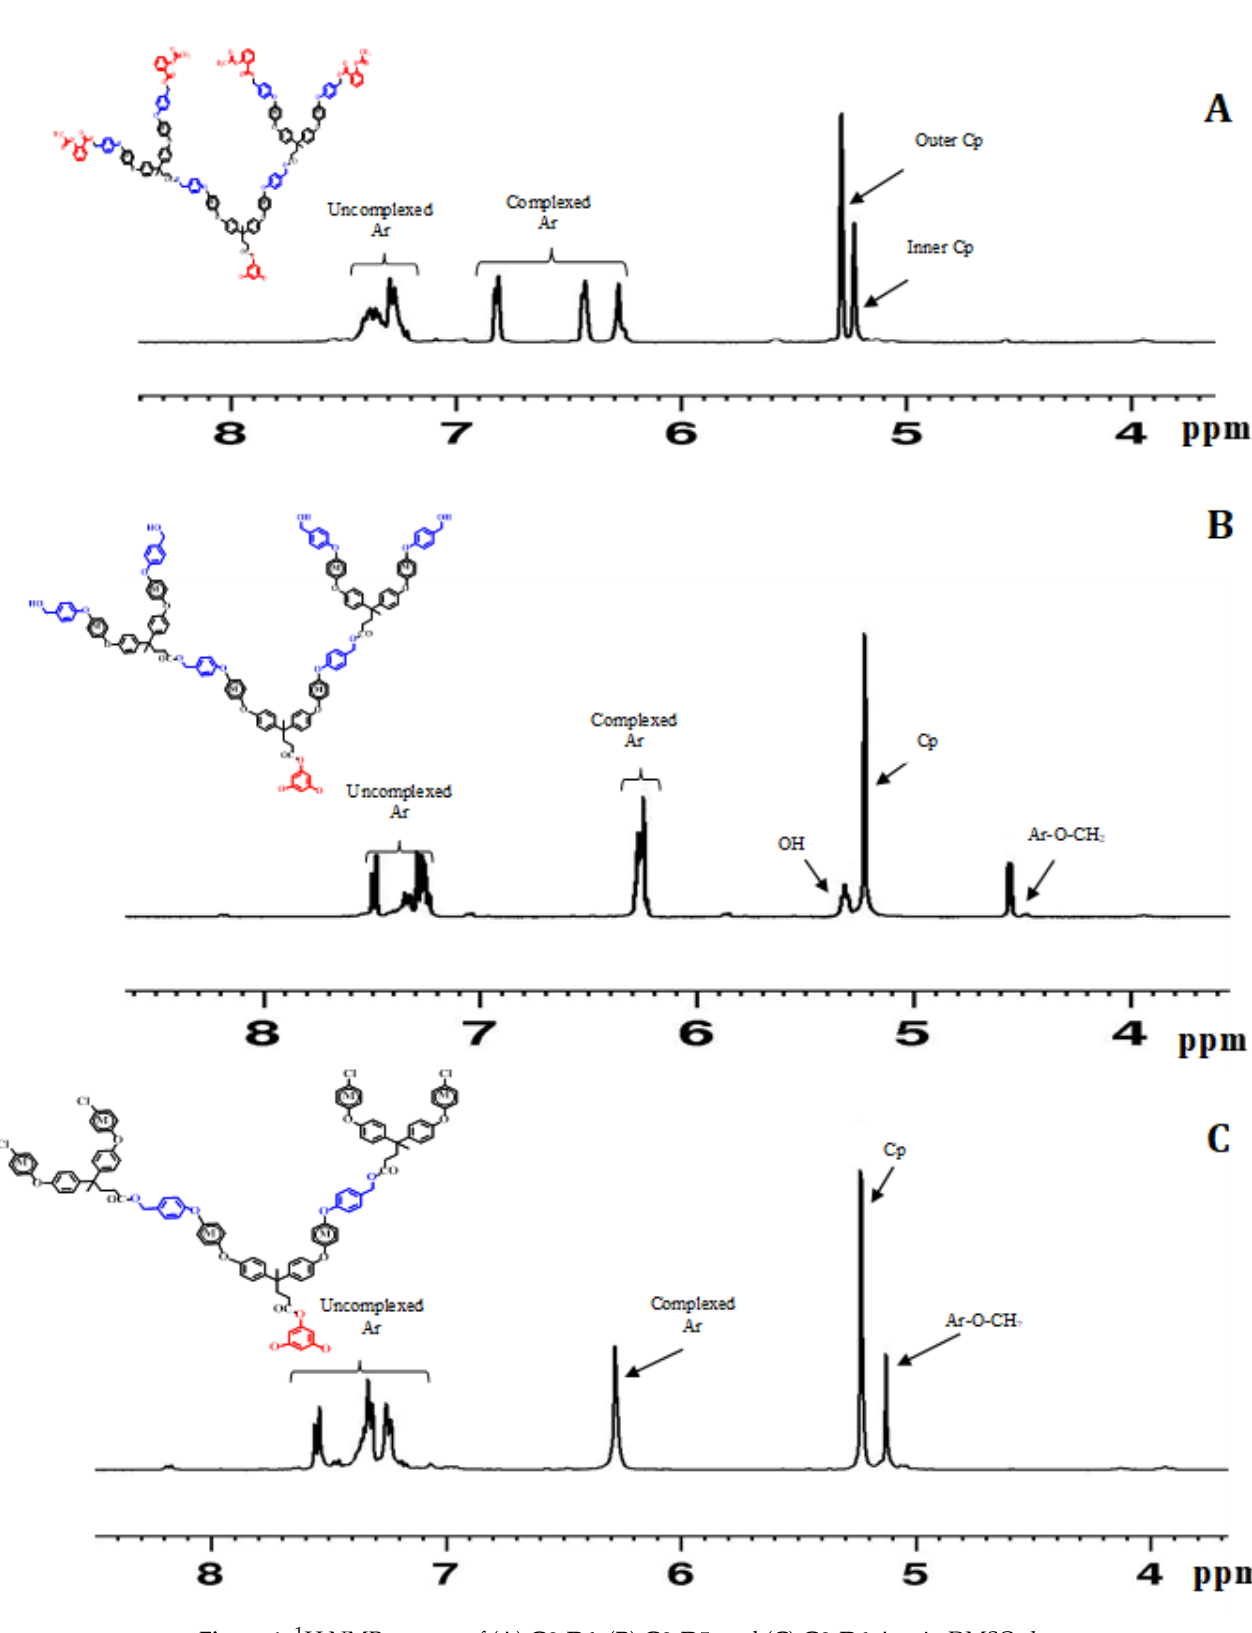
Figure Figure 1. 1 H NMR spectra of ( A ) G2-D4 , ( B ) G2-D5 , and ( C ) G2-D6-Asp in DMSO-d 6 .